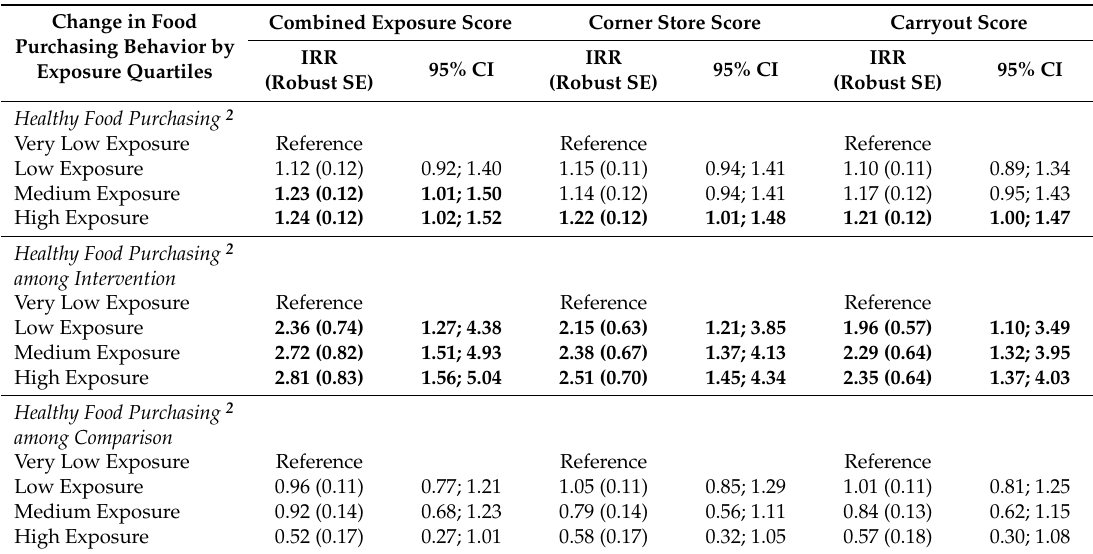
Table 5. Change in healthy food purchasing behavior over time by quartile of exposure level among BHCK children ( n = 385).